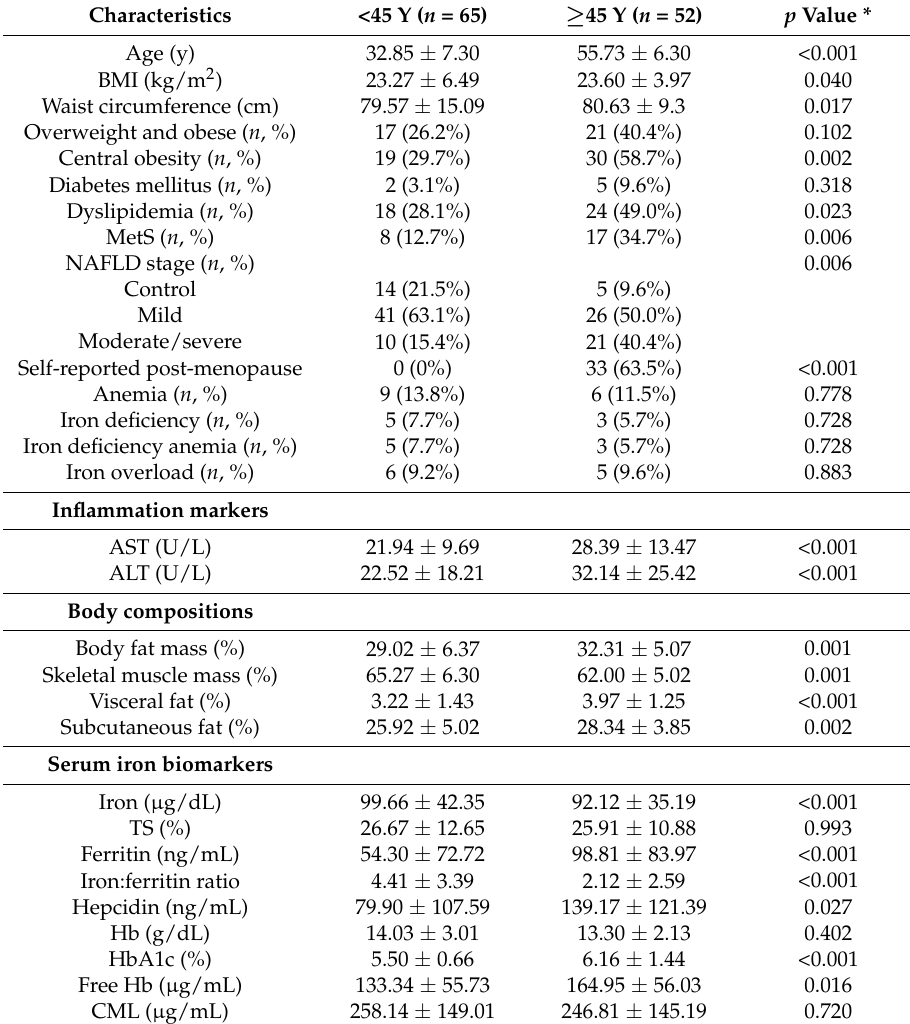
Table 1. Clinical characteristics of women stratified by